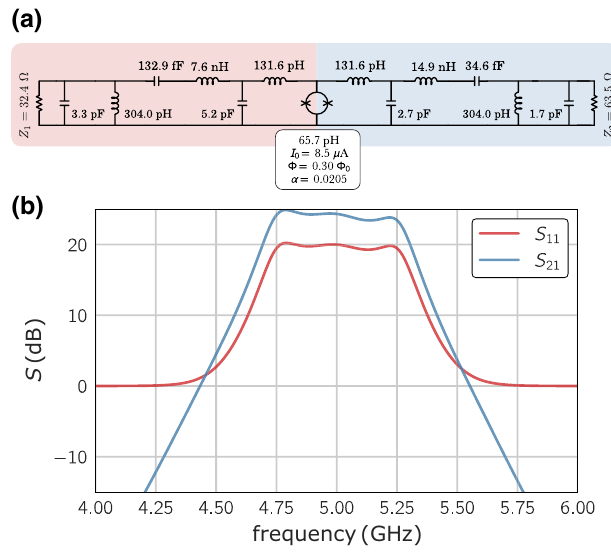
FIG. 25. (a) Example nondegenerate amplifier circuit based on the three-pole Chebyshev graph in Fig. 20, centered at 5 GHz (signal) and 7 GHz (idler). (b) Calculated S parameters for a matched parametric amplifier (referred to the port impedances Z 1 and Z 2 , not to 50 (cid:8) ). Here S 11 is the signal reflection cis- gain, and S 21 is the signal-idler trans-gain. In contrast to Fig. 20, these represent the power gain rather than the photon number gain; therefore, S 21 has an extra overall relative scaling factor f 2 Z 2 / f 1 Z 1 (4.4 dB at 5.0